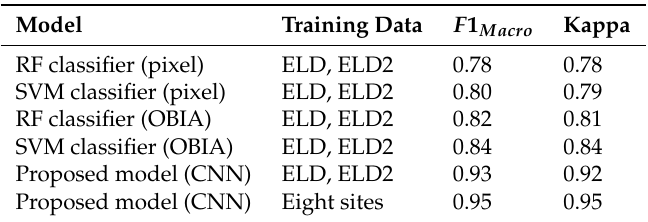
Table 4. Model comparison.